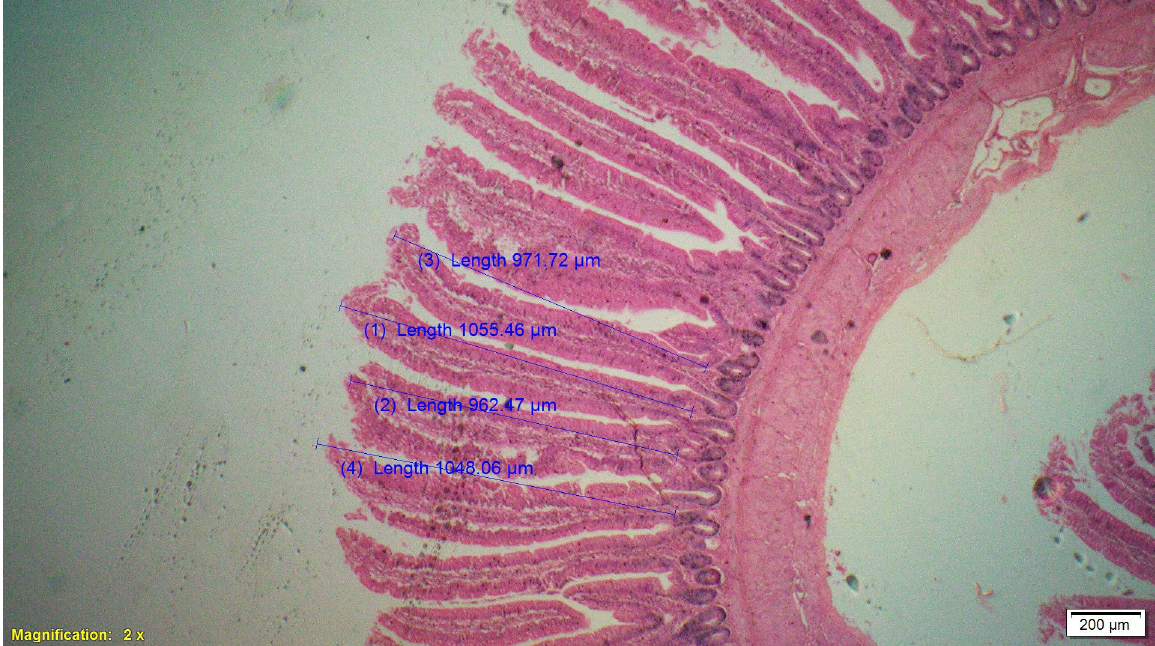
Fig 5. Photomicrograph of the cross section of Jejunum from chicory + coriander group (T5), H&E, 2x.